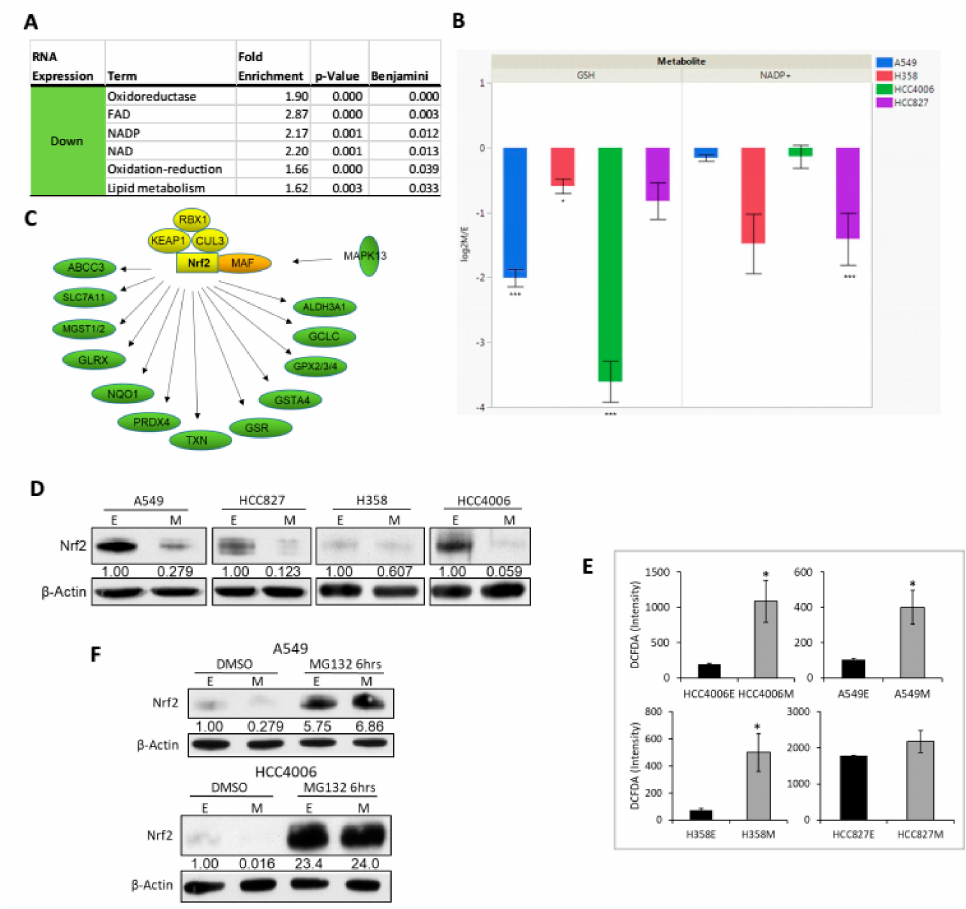
Figure 4. Wild type and mutant KEAP1 mesenchymal state cells show attenuated Nrf2 protein and activity. ( A ) Enrichment of down regulated redox and lipid metabolic genes correlated with M state (DAVID). ( B ) Reduced abundance of glutathione and NADP + as measured by LC-MS / MS with log2 fold change M / E ( p < 0.05 *; p < 0.01 **; p < 0.001 ***). ( C ) Down regulation (green) of Nrf2 / NFE2L2 target genes in the mesenchymal state supports reduced Nrf2 activation in the mesenchymal state. Nrf2 associated transcription factor MAF was markedly increased (orange), with little / no change in Nrf2 protein stability regulators KEAP1, CUL3, and RBX1 (yellow). ( D ) Nrf2 levels decrease in the M state at the protein level in all four EMT models. ( E ) Reduced Nrf2 protein in M state cells correlates with increased ROS as measured by flow cytometry. ( F ) Both E and M state cells turnover Nrf2 protein via proteasomal degradation. A549 and HCC4006 were treated with proteasome inhibitor MG132 for 6 h followed by immunoblot for Nrf2 and β